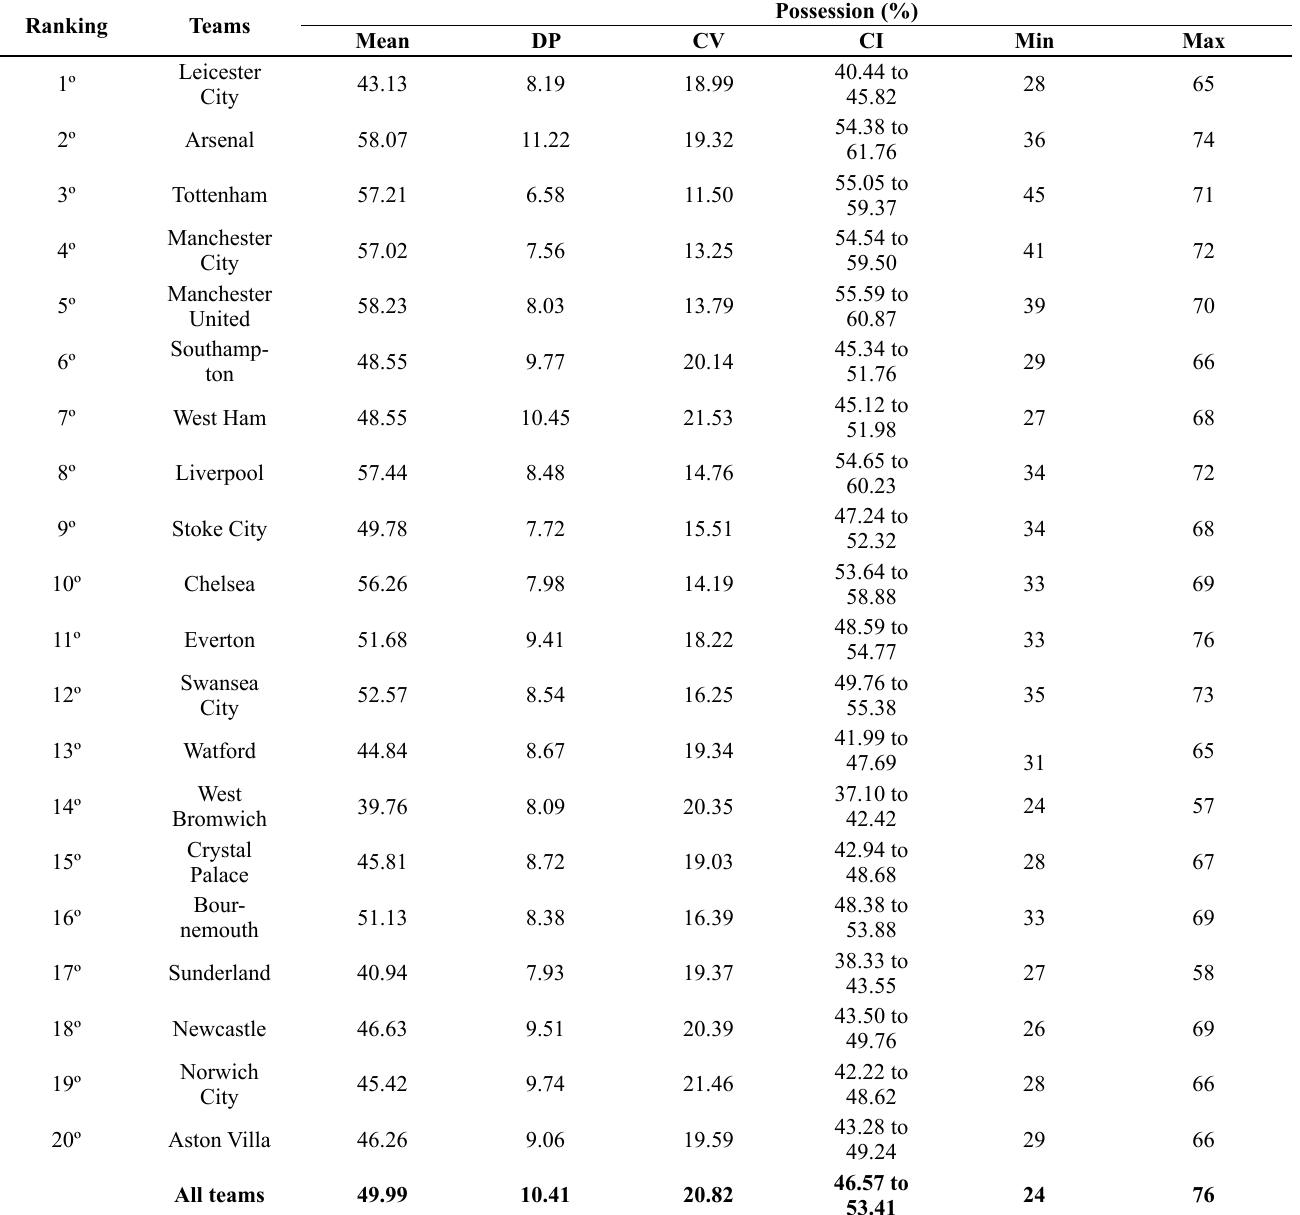
Table 1. Descriptive statistics (mean, standard deviation [DP], coefficient of variation [CV], 95% confidence intervals [CI], minimum [Min], maximum [Max]) of the possession during the England Premier League season 2015/16. Ranking